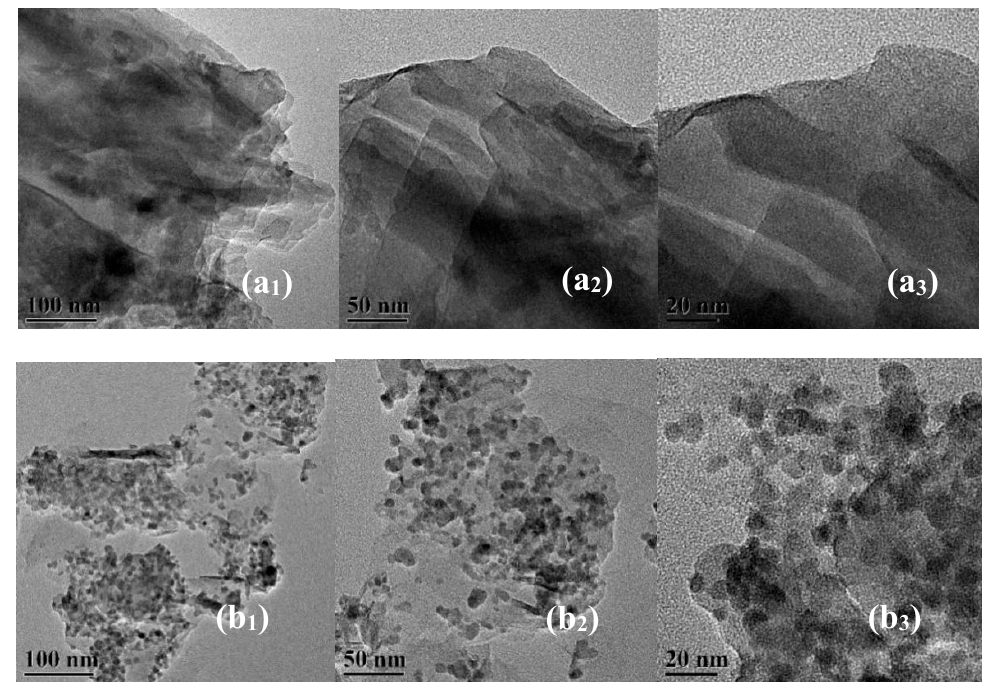
Figure 3. Transmission electron microscopy (TEM) images of ( a 1 ,100 nm; a 2 ,50 nm; a 3 ,20 nm) MMT-k10 and ( b 1 ,100 nm; b 2 ,50 nm; b 3 ,20 nm) CuFe 2 O 4 /MMT-k10.